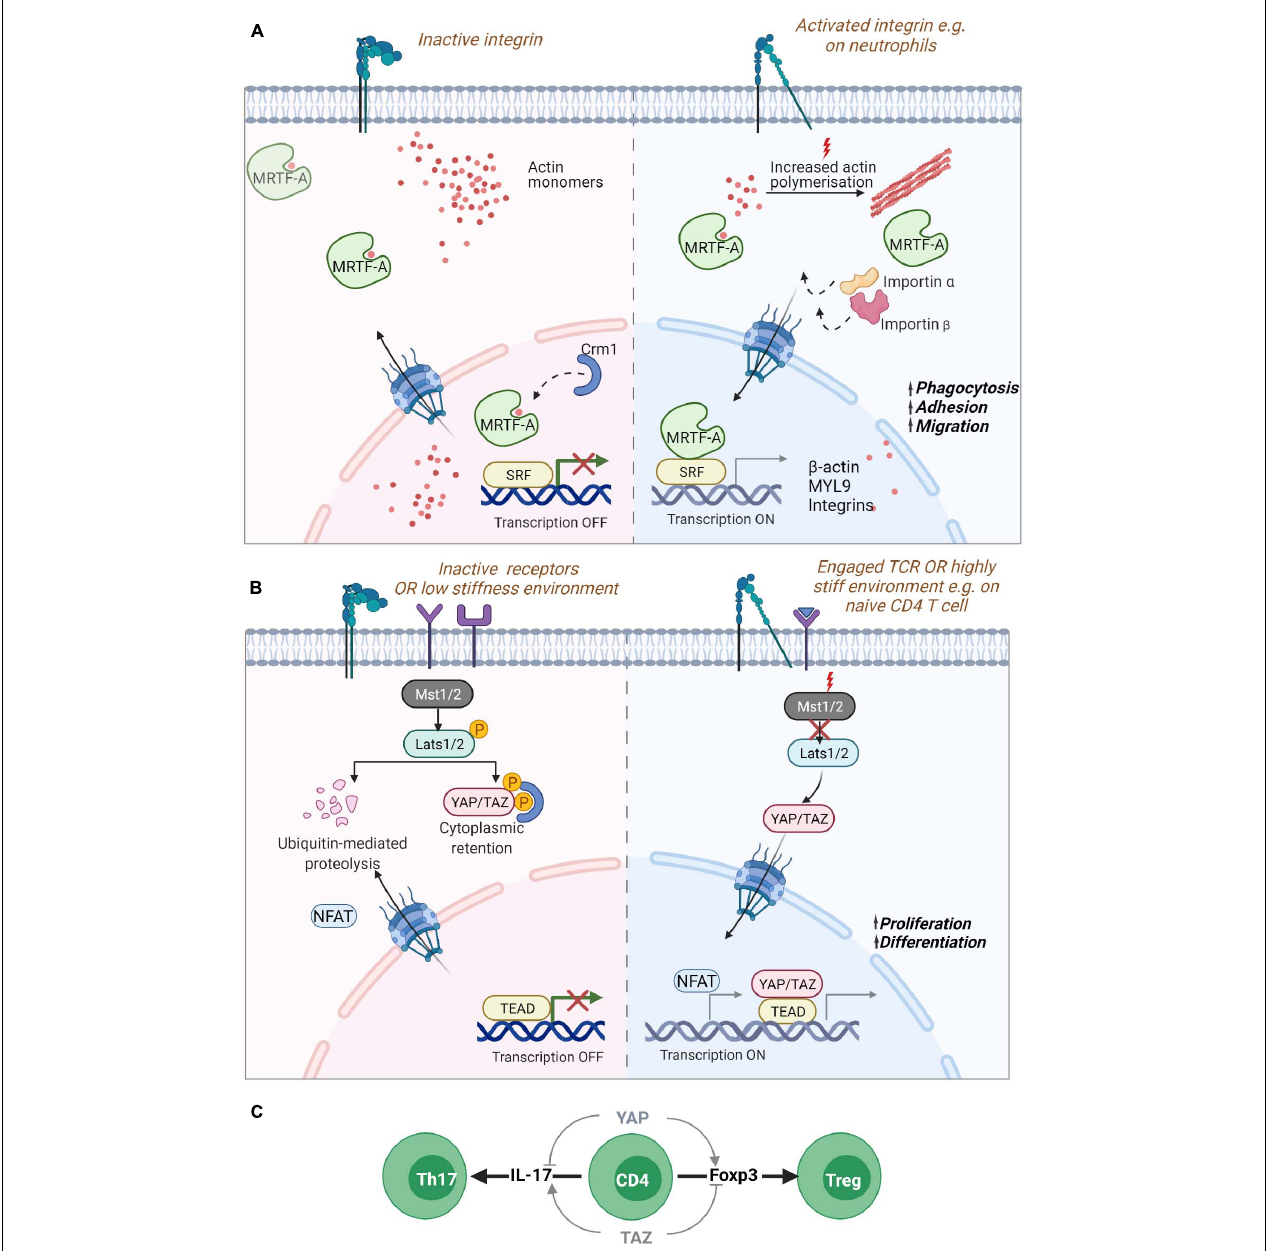
FIGURE 3 | Nucleo-cytoplasmic shuttling proteins . Mechanical information from the cell surface can be transduced to the nucleus through the shuttling of gene regulators such as (A) MRTF-A/MKL1 or (B) YAP or TAZ. (A) MRTF-A contains two RPEL domains that can bind to monomeric actin sequestering them in the cytoplasm. Reduction of actin monomers due to filament build up in the cytoplasm leads to the exposure of NLS sequences in MRTF-A, promoting its transport via the chaperones importin α / β into the nucleus. Inside the nucleus, reduced levels of monomeric actin enable its binding to SRF transcription factors for the expression of cytoskeletal genes. Increased levels of monomeric actin in the nucleus in turn promote its association with Crm1 chaperone and export from the nucleus. MRTF-A nuclear translocation is also regulated by phosphorylation (not shown). In neutrophils, MRTF-A is known to drive the expression of β -actin, myosin light chain (MLC) and integrins promoting phagocytosis, adhesion and migration. (B) The YAP/TAZ proteins are retained in the cytoplasm via phosphorylation through activated Lats1/2 kinase targeting the proteins for degradation or retention. Mechanosensitive signaling leading to reduced phosphorylation of Lats1/2 by Mst1/2 leads to hypo-phosphorylation of the protein and its translocation to the nucleus for association with TEAD containing transcriptional regulators. YAP regulates the enhanced proliferation of T cells on stiff environments. (C) During naïve T cell differentiation, YAP and TAZ have opposing effects. The expression of the YAP paralog promotes Foxp3 expression and thus, regulatory T cell formation while also inhibiting IL-17 expression Th17 differentiation. While TAZ promotes Th17 differentiation and blocks Treg differentiation. Myocardin Related Transcription Factor A (MRTF-A)/Megakaryoblastic leukemia 1 protein (MKL1); Yes-associated protein (YAP) and its paralog WW Domain-Containing Transcription Regulator Protein1 (WWTR1/TAZ); Nuclear localization signal (NLS); Serum response factor (SRF); TEA domain family (TEAD).